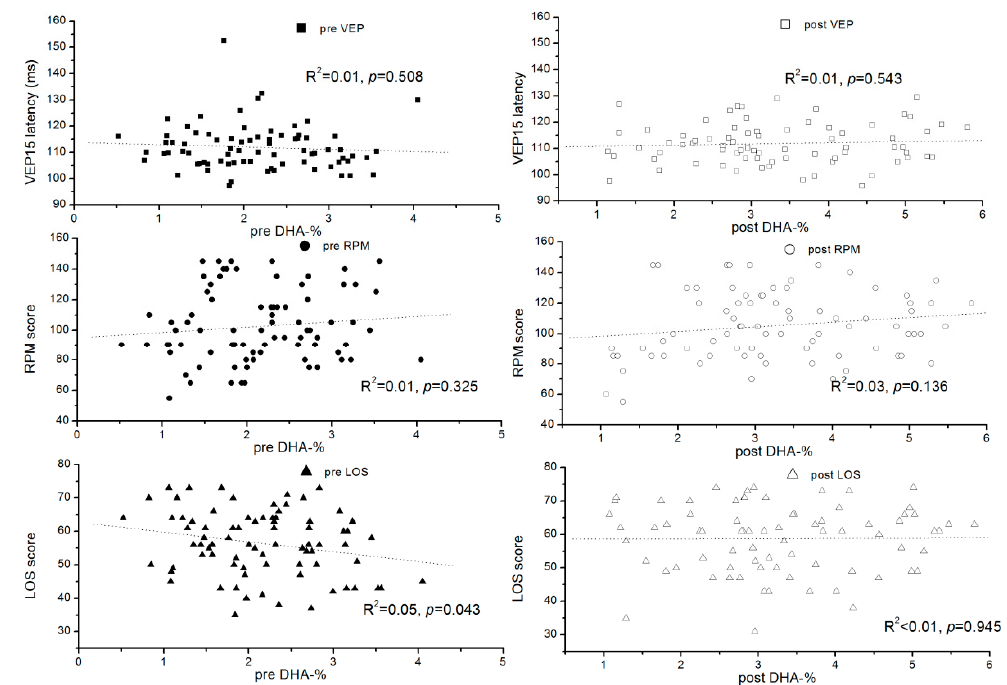
Figure 2. Association of the latency of visually evoked potentials with pattern size 15´ (VEP15 latency), the Ravens score (RPM), and the Lincoln-Oseretzky score (LOS) with the percentage of DHA in plasma glycerophospholipids before (pre) and after (post) intervention.